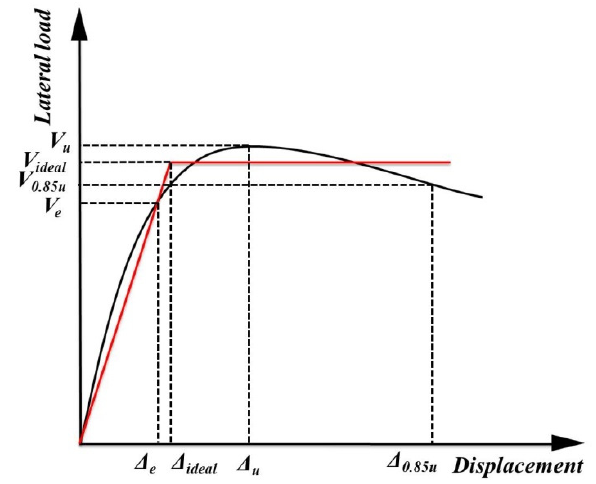
Figure 9. Idealized equivalent elastic-plastic system. Table 3. Idealized elastic-plastic envelope parameters and equivalent displacement ductility.